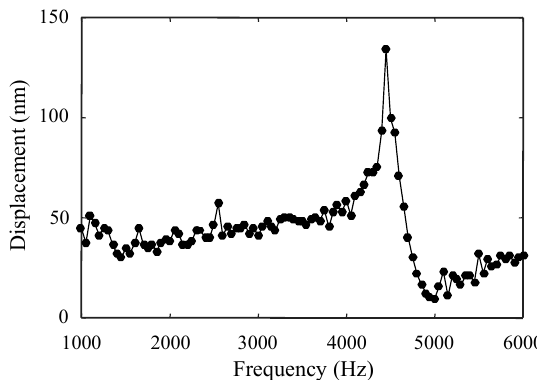
Figure 9. Resonance frequency measurement of release MEMS structure.